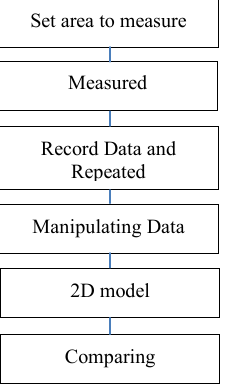
Figure 9. Agatec Distometer method procedures